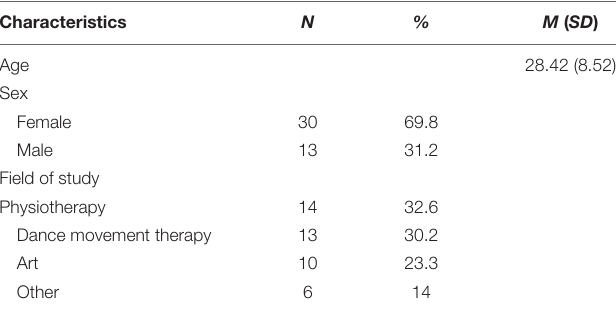
TABLE 2 | Participants’ demographic characteristics ( N =